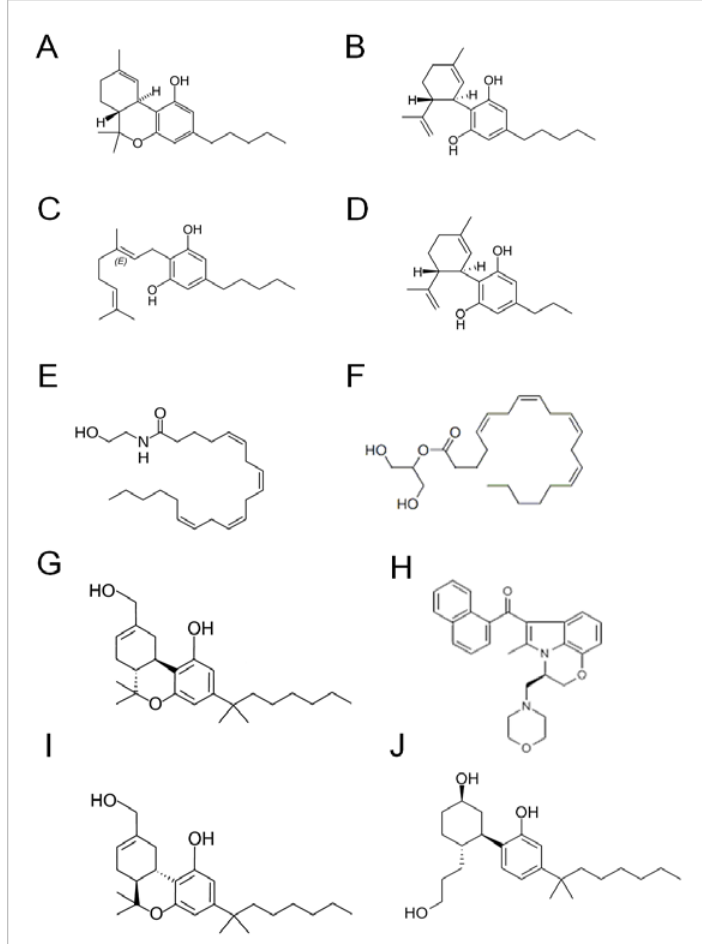
Figure 1. Cannabinoid structures. (A) Delta 9 -tetrahydrocannabinol (delta 9 -THC); (B) cannabidiol (CBD); (C) cannabigerol (CBG); (D) cannabidivarin (CBDV); (E) anandamide (AEA); (F) 2-arachidonyl glycerol (2-AG); (G) HU210; (H) WIN55, 212-2; (I) HU211; (J) CP55940; (A)–(D) natural cannabinoids; (E) and (F) endocannabinoids; (G)–(J) synthetic